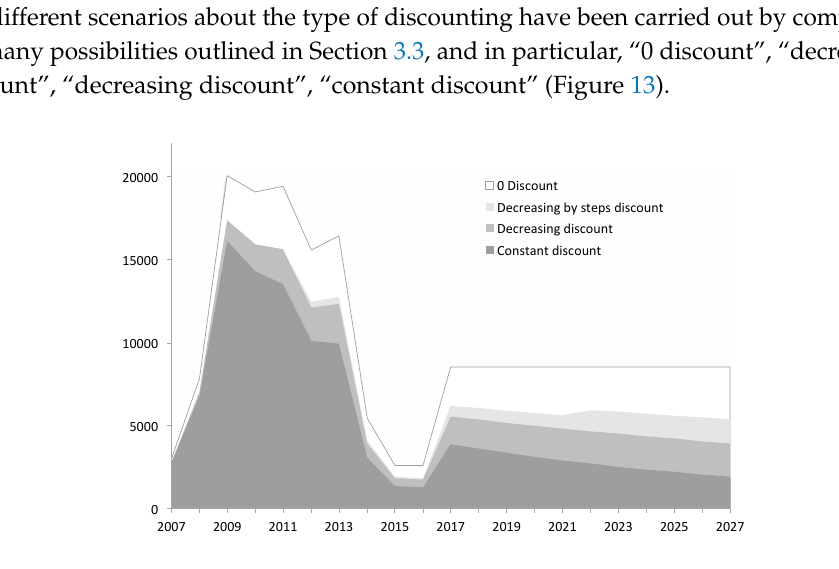
Figure 13. Scenarios of the Net Present Values (the white and grey surfaces) of the imputed expenditure cash flow according to different hypotheses of inter-generational solidarity (y-axis: 000EUR).